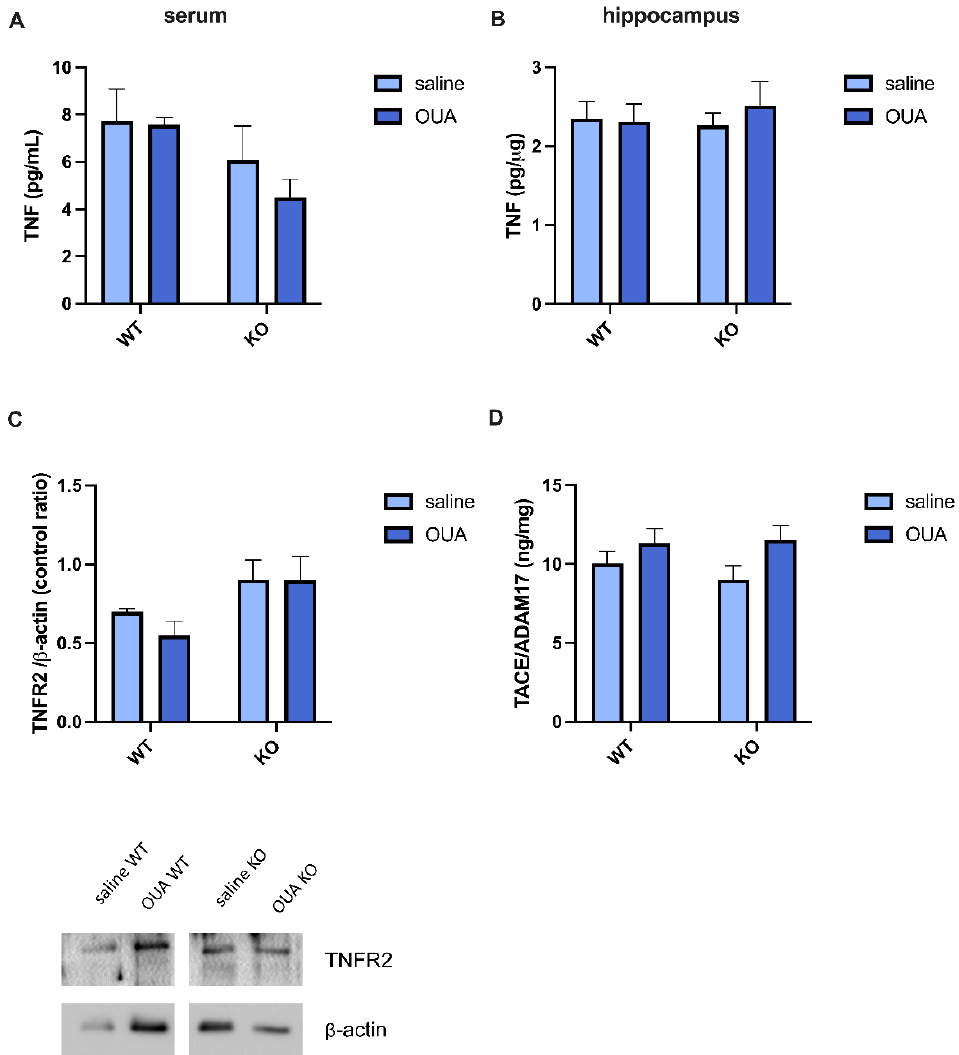
Figure 1. Effect of ouabain and the lack of TNFR1 in TNF levels, TNFR2 expression, and TACE/ADAM17 activity. ( A ) TNF levels in serum were not changed by ouabain treatment or the TNFR1 gene. ( B ) TNFR1 KO mice presented the same TNF levels as WT mice in hippocampus. ( C ) Densitometric analysis and representative Western blotting of TNFR2 membrane expression. There was an increase in TNFR2 expression in the membrane enriched fraction for the gene factor [F (1,30) = 5.591]. ( D ) The activity of TACE/ADAM 17 was raised for ouabain treatment [F (1, 16) = 4563]. Results are expressed in pg/mL for serum samples ( n = 11, N = 3) and pg/ υ g (mean ± SEM) in hip- pocampal samples ( n = 4, N = 2) for TNF measurements, in control ratio for TNFR2 expression ( n = 5, N = 2), and ng/mg in TACE/ADAM 17 activity ( n = 5, N = 1). Two-way ANOVA was performed for the comparison followed by Tukey´s post-test.